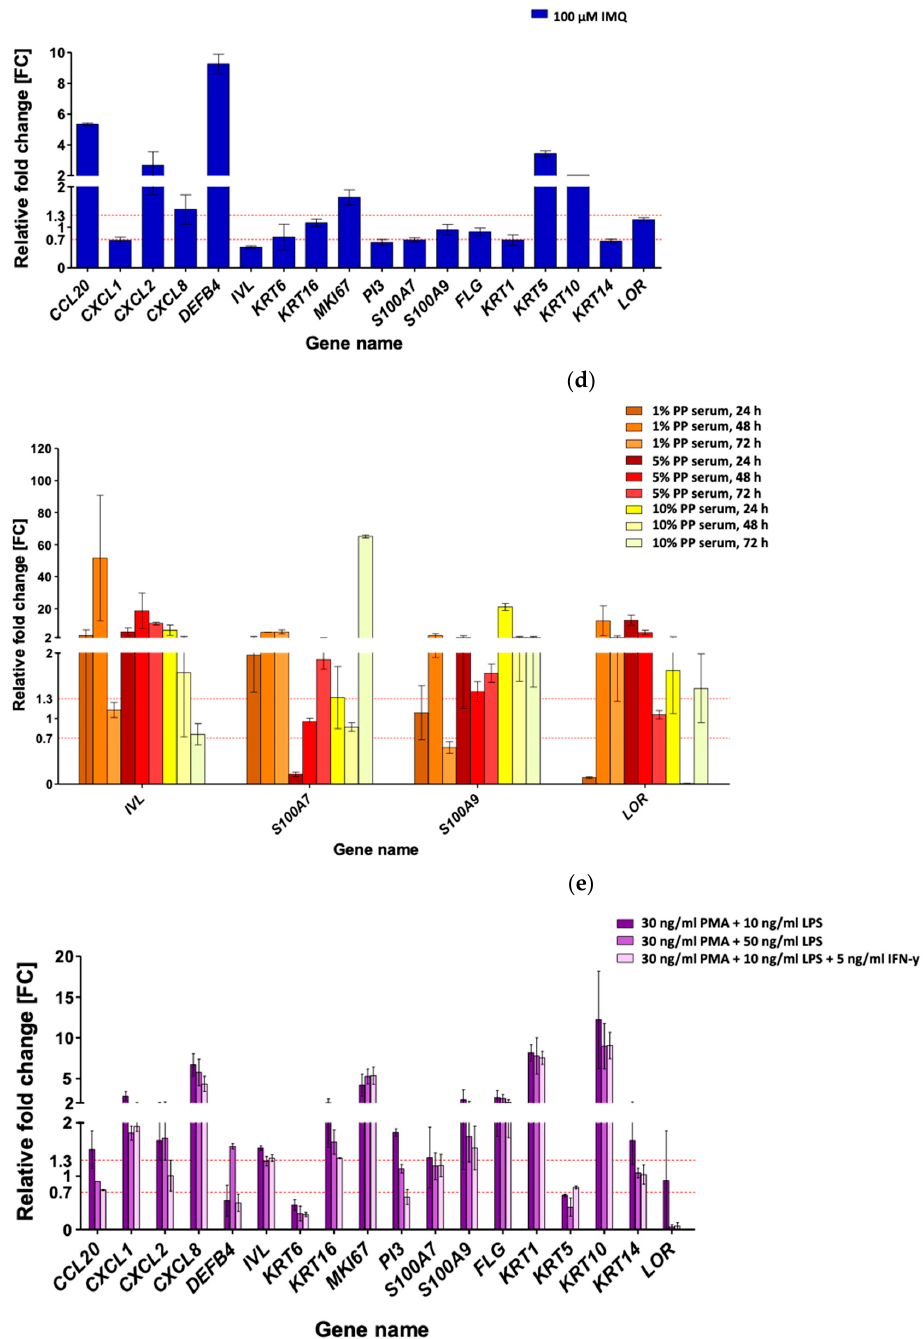
Figure 1. Alterations in mRNA levels (fold change (FC): increase/decrease marked with a horizontal red dotted line, i.e., FC ≥ 1.3 and ≤ 0.7) of selected genes in in vitro psoriasis (Ps)-like inflammation models with cytokine mix (5MIX) at calcium (Ca 2+ ) ≤ 0.1 mM or Ca 2+ = 2 mM ( a ) for HaCaT and ( b ) for pKC; imiquimod (IMQ) ( c ) for HaCaT and ( d ) for pKC; and serum-induced monoculture ( e ) for HaCaT of keratinocytes, and phorbol 12-myristate 13-acetate (PMA), lipopolysaccharide (LPS), and interferon gamma (IFN- γ ) co-culture of HaCaT and THP-1 ( f ). The real-time qRT-PCR data represent averaged values ± standard deviation from three independent culture replicates ( n = 3), with three technical repeats each ( N = 3), and denote significant differences for tested samples, with respect to the reference gene TBP , of a constant expression level implemented for the analysis. Determination of potential candidates for endogenous control as reference genes for real-time qRT-PCR was assessed using the commercially available RealTime ready Human Reference Gene Panel. In addition, analyses of the normalised gene expression data were performed in Prism